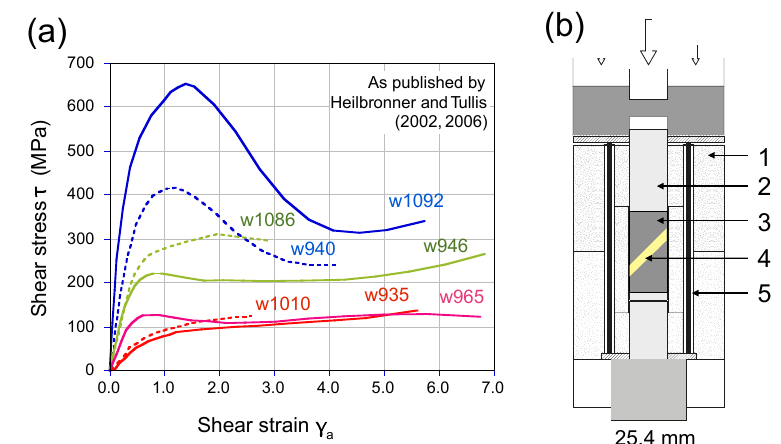
Figure 1. General shear experiments on Black Hills Quartzite. Shear stress ( τ ) vs. shear strain ( γ ): blue is regime 1, green is regime 2, red is regime 3, the stippled line represents relatively low finite strain, and the solid line represents relatively high finite strain (compare Table 1). On the right, a simplified drawing of the sample assembly for general shear experiments: 1 is the confining medium (NaCl), 2 is the axial load/ σ 1 piston (Al 2 O 3 ), 3 is the quartz single crystal forcing block, 4 is the quartzite sample at 45 ◦ with respect to σ 1 piston, and 5 is the furnace (carbon, pyrophyllite). Shear strain is an apparent shear strain, and data are recalculated as described in the